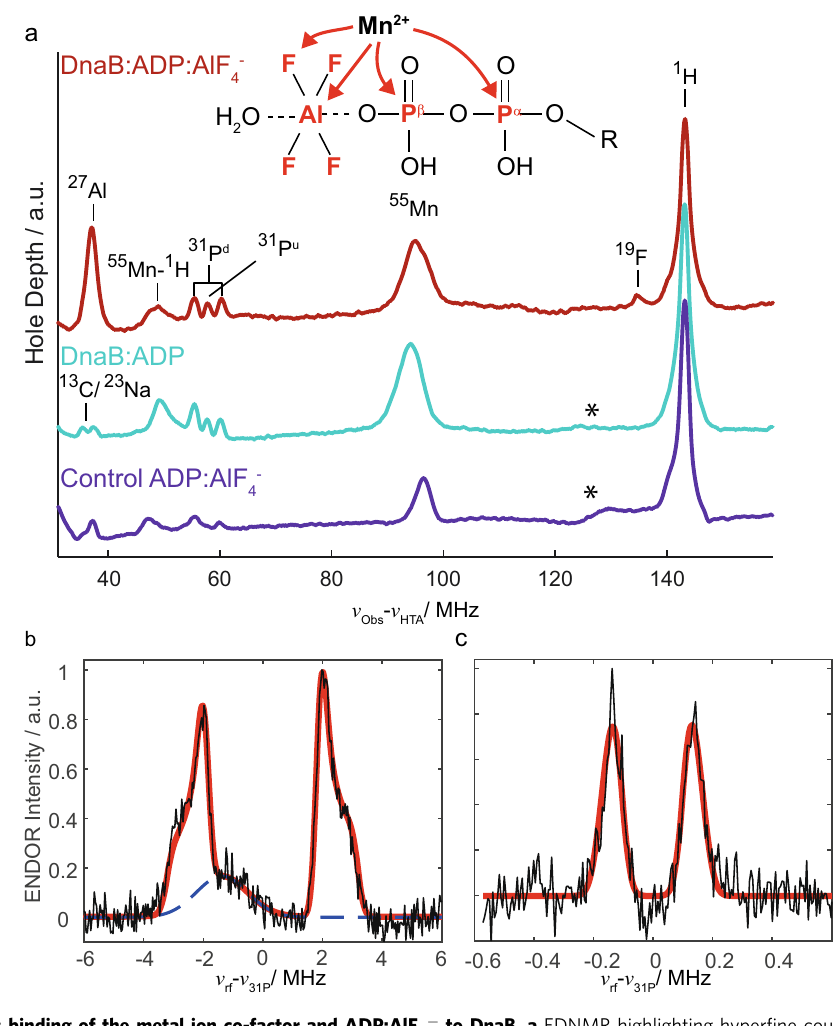
Fig. 2 EPR characterizes binding of the metal ion co-factor and ADP:AlF 4 − to DnaB. a EDNMR highlighting hyper fi ne couplings and thus proximities between the Mn 2 + metal center and surrounding nuclei measured for DnaB:ADP:AlF 4 − (red) and DnaB:ADP (cyan), as well as for a control solution containing only Mn 2 + :ADP:AlF 4 − in the same buffer used for the protein sample (purple). The assignments of the peaks to the nuclear resonance frequencies are shown. The cyan spectrum is reproduced from ref. 64 . Asterisks mark a broad, currently unassigned feature that is possibly due to Mn double quantum or combination lines 23 . 31 P Davies ENDOR ( b ) and Mims ENDOR ( c ) recorded on DnaB:ADP:AlF 4 − . The red lines represent line shape simulations using EasySpin 106 based on A iso -values of 0.3 and 4.7 MHz (for all parameters see Supplementary Table 1). The broad background peak in ( b ) is most likely a third harmonic of one of the Mn 2 + hyper fi ne lines and was removed for fi